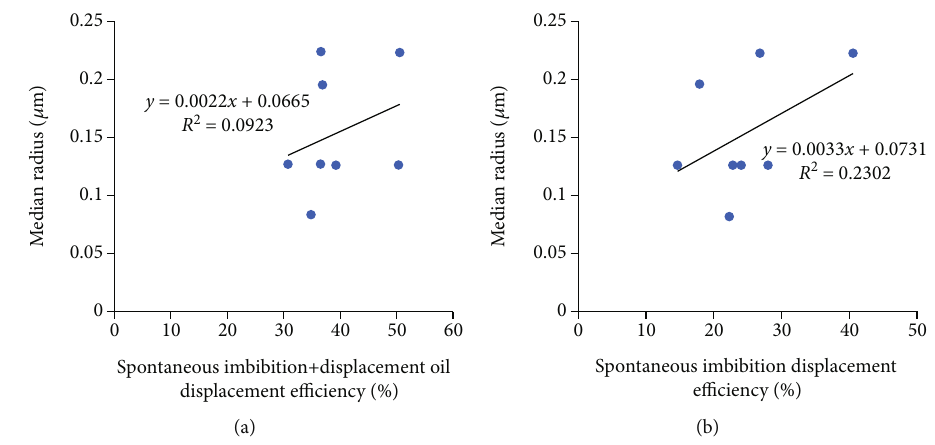
Figure 10: Correlation between oil displacement e ffi ciency and median radius.